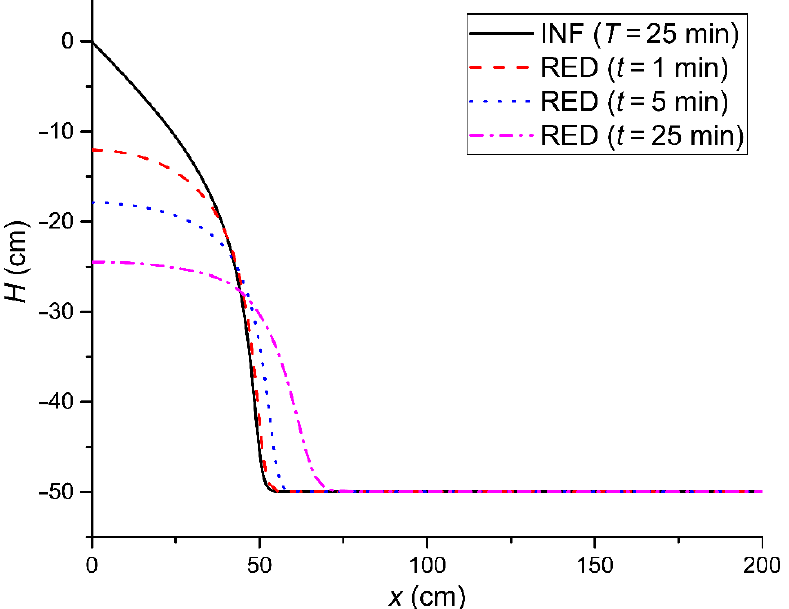
Figure 3. The relation of the soil water pressure head Η with the horizontal distance x , Η (x) , at the end of the horizontal infiltration (INF) with duration T = 25 min and during the redistribution (RED) with hysteresis being included (HY) at times t = 1, 5, and 25 min, after the cessation of the infiltration making use of the boundary wetting H– θ curve. The initial soil water content before the commencement of the infiltration was θ o = 0.12 cm 3 cm − 3 ( H = − 49.9 cm).